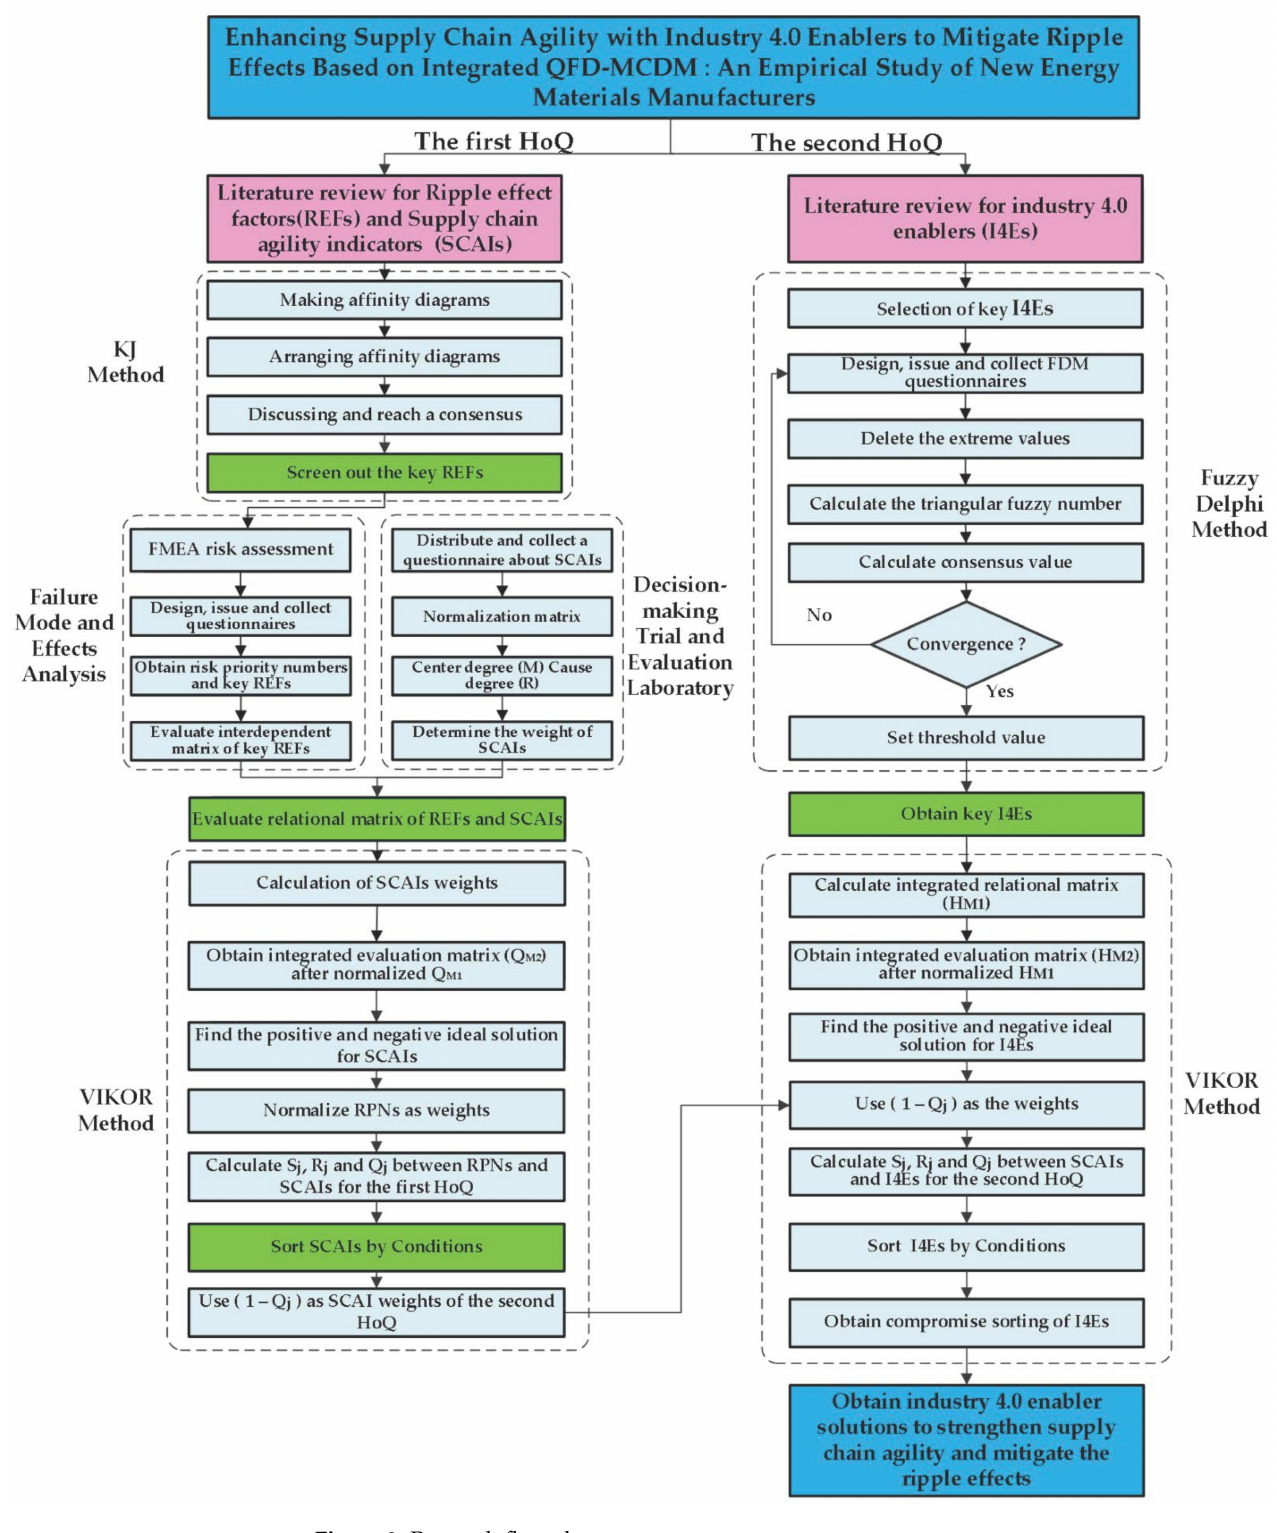
Figure 2. Research flow